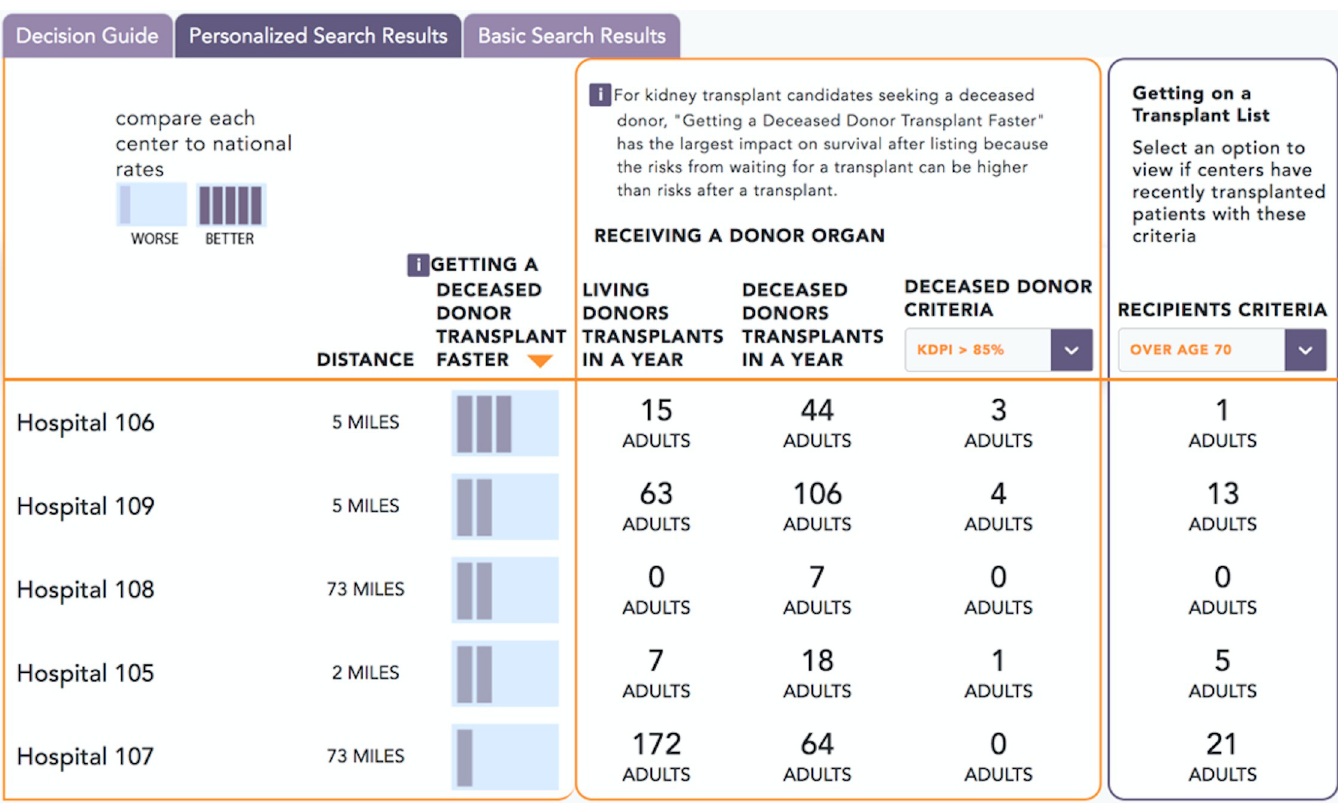
Fig 5. Development website screenshot of a search results for a transplant center within a provided radius. The page includes center outcomes and the characteristics of patients at a center and donors at a